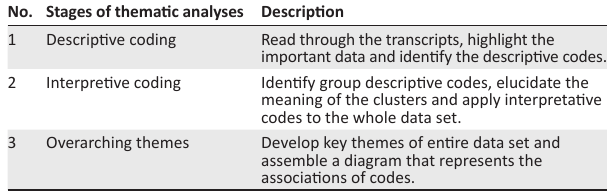
TABLE 2: Data analysis procedures. Descriptive